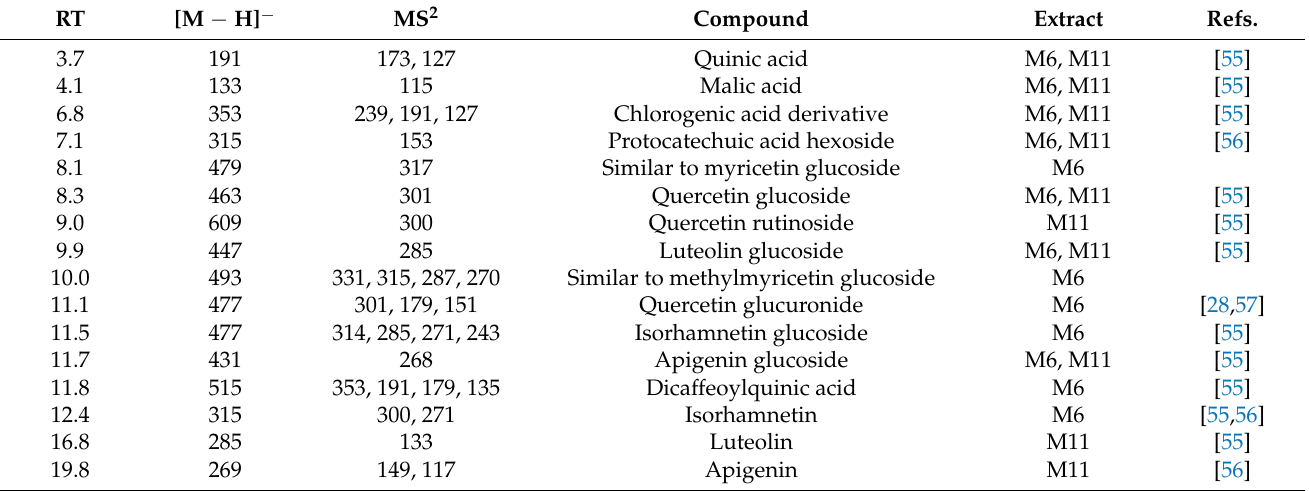
Table 3. The phenolic compositions of methanol extracts obtained from A. biebersteinii and A. mille- folium subsp. millefolium